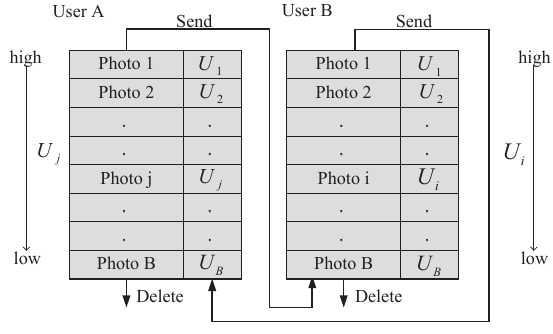
Figure 4. The management process in the user’s storage.